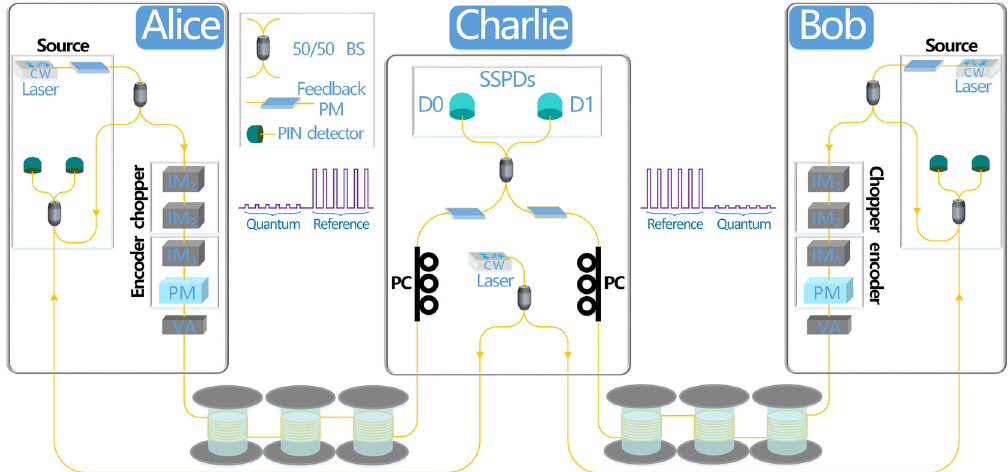
FIG. 1. Experimental setup to implement the twin-field quantum key distribution . CW laser, continuous-wave laser; IM, intensity modulator; PM, phase modulator; VA, variable attenuator; 50 = 50 BS, beam splitter with a 50 = 50 splitting ratio; PC, polarization controller; SSPDs, superconducting single-photon detectors. Alice and Bob have the same setup, which mainly consists of the source, chopper, and encoder modules. The source generates the laser with a locked frequency and phase with the laser from Charlie. The chopper is used to first modulate the CW laser into a pulse train (IM 1 ) and then chop it into time-multiplexed bright reference and weak quantum parts (IM 2 ). The encoder adds code or decoy information into the quantum part (IM 3 and